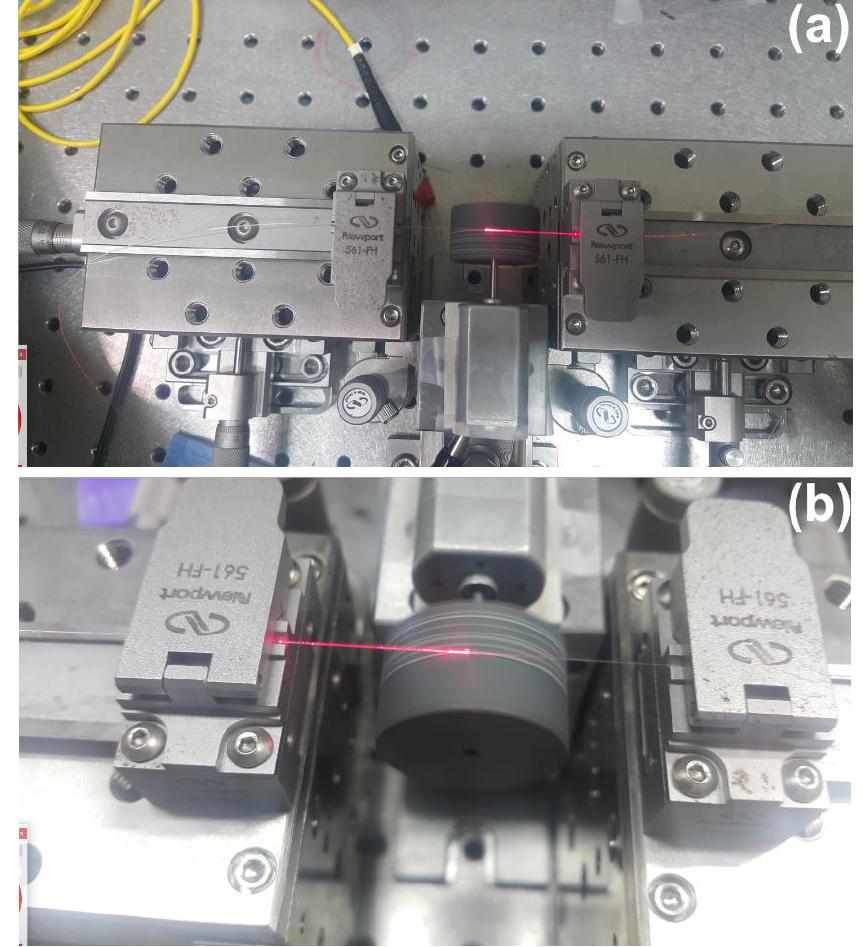
Figure 9. Polisher design setup; ( a ) the stage used to hold the fiber; and ( b ) the polishing process, where the light is figuring out from the fiber due to a removal of the cladding.